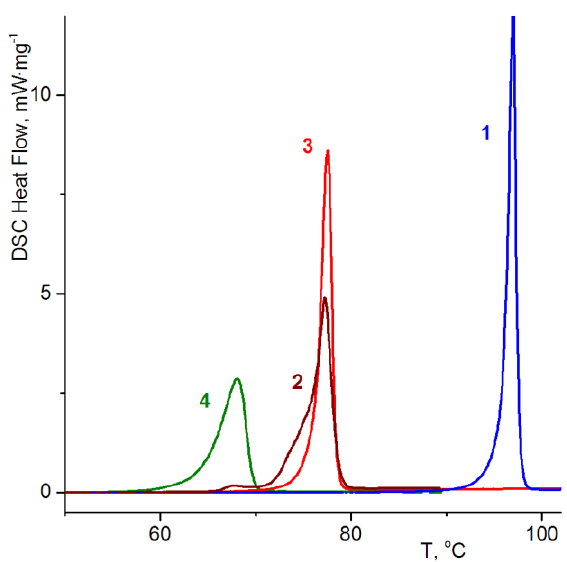
Figure 2. Di ff erential scanning calorimetry (DSC)traces of an enantiopure sample ( R )- 1 (blue curve 1), a freshly recrystallized racemic sample rac - 1 (wine curve 2), the same sample after prolonged stirring of a suspension in hexane (red curve 3), and after crystallization of the racemate from the melt (olive curve 4). Sample weight ~ 1 mg. Table 3. Thermochemical characteristics of the identified crystalline forms of 3-(3,4-dimethylphenoxy) propane-1,2-diol 1